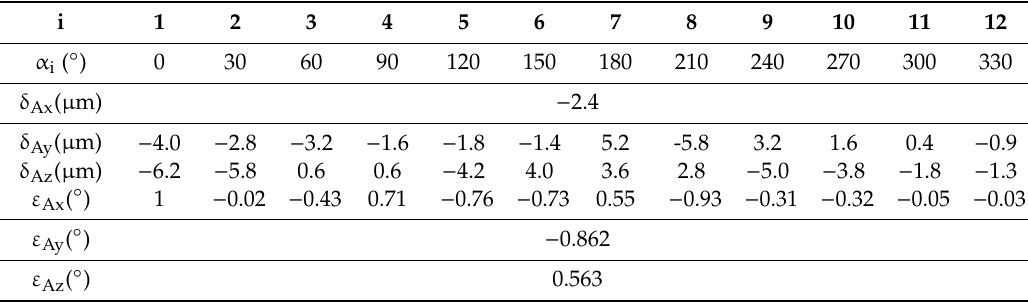
Table A4. Complete geometric errors of the A-axis.